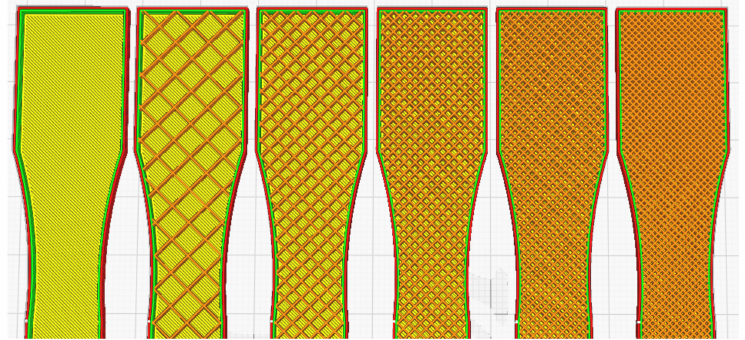
Figure 2. Infill density of sample: 0%, 20%, 40%, 60%, 80% and 100% (left to right).